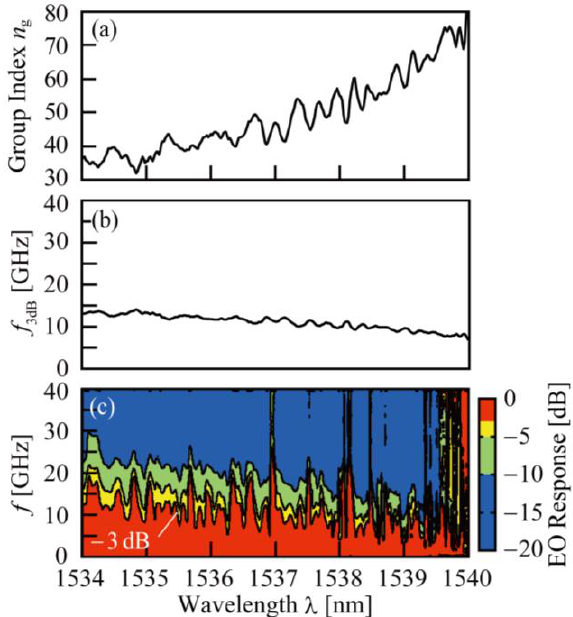
Figure 8. Characteristics of PCW device without lattice shifts in the wide wavelength range: ( a ) n g spectrum; ( b ) f 3dB spectrum calculated from Equations (2) and (3) with the measured n g and EE S 21 estimated with R = 96 Ω and C = 50 fF; ( c ) Frequency response spectrum R ( f , λ).